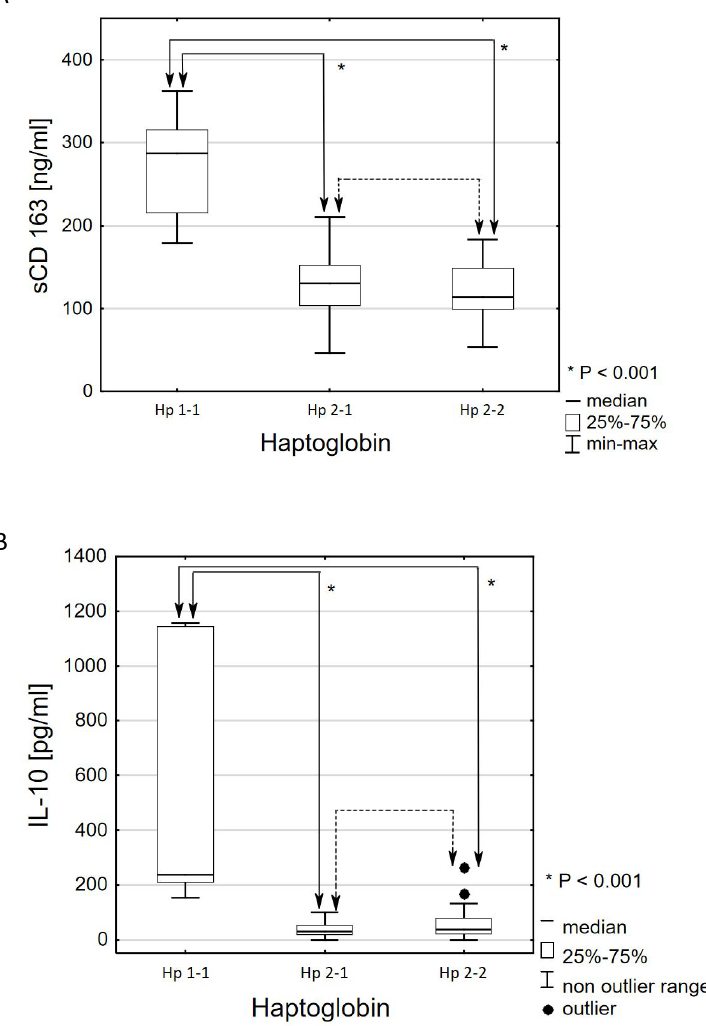
Figure 1. E ff ect of haptoglobin phenotype on serum soluble form of CD163 receptor (sCD163) ( A ) and interleukin 10 (IL-10) ( B ) concentration in patients with type 2 diabetes. The sCD163 concentration is expressed as ng / mL serum ± interquartile range (IQR). The IL-10 concentration is expressed as pg / mL serum ± IQR. * p < 0.001—statistical significance between Hp1-1 (control group) and Hp2-1 or Hp2-2. p > 0.05—no statistically significant di ff erences between Hp2-1 and Hp2-2. Hp1-1—haptoglobin